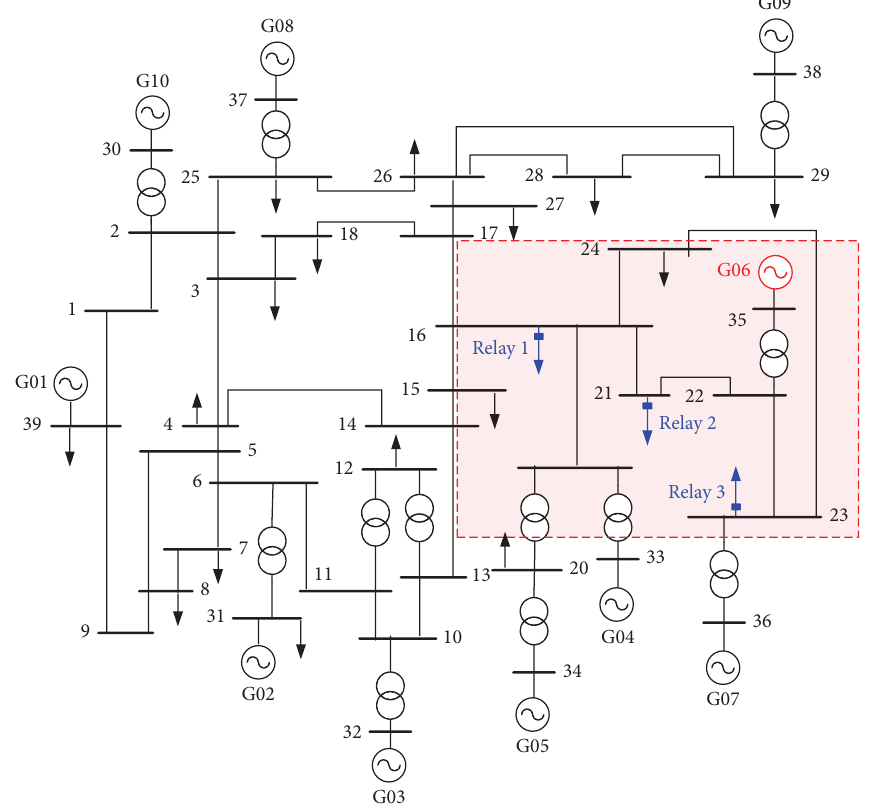
Figure 5: Representation of the UFLS scheme installed in the IEEE-39 bus